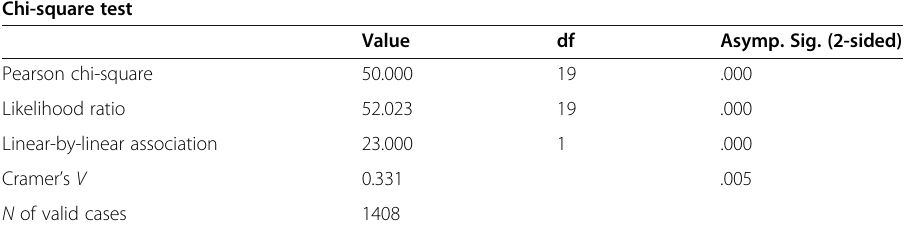
Table 8 Pearson chi-square test of TA and PA x descriptive and narrative